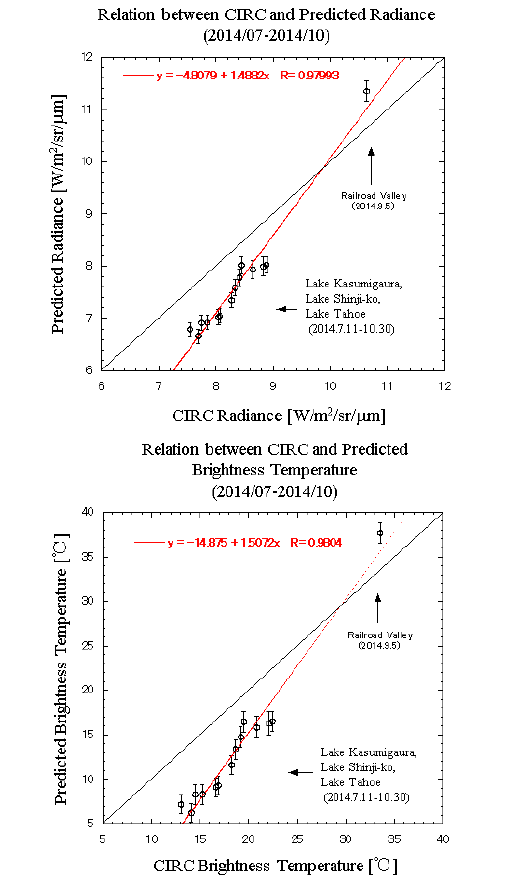
Figure 10. Relation between observed CIRC data and predicted values about Radiance and Brightness Temperature.